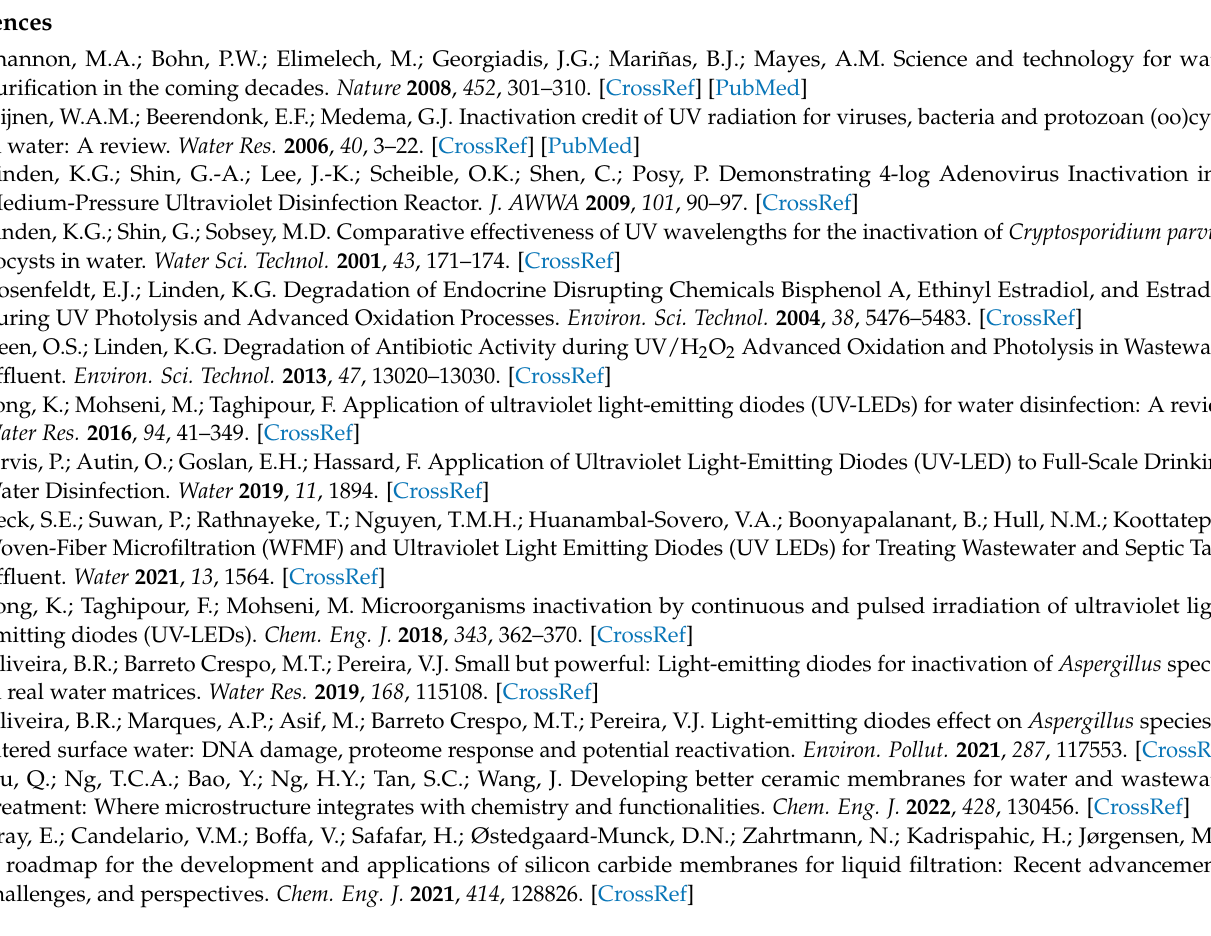
(b) Membrane filtration system; (c) Combined treatment system. Figure S2. Scanning electron microscopy images obtained for the non-modified and modified membrane: top surface (up) at × 3000 magnification and cross section (down) at × 500 magnification. Figure S3. Scanning electron microscopy with energy-dispersive X-ray spectroscopy mapping obtained for the Si and Ti atoms for non-modified (up) and modified (down) membranes. Table S1. Atomic composition in percentage of C, O, Si and Ti atoms analyzed for membranes (non-modified and modified) before filtration assays. Table S2. UV fluence values (mJ/cm 2 ) for each wavelength and exposure time. Table S3. Inactivation rate constants. Figure S4. Rejection percentage of total coliforms, E. coli and fungi after dead-end filtration using the non-modified and modified membranes. Figure S5. Rejection percentage of total coliforms, E. coli and fungi after dead-end filtration of the non-modified membrane (a) and the modified membrane (b) with LEDs that emits at 255, 265 and 365